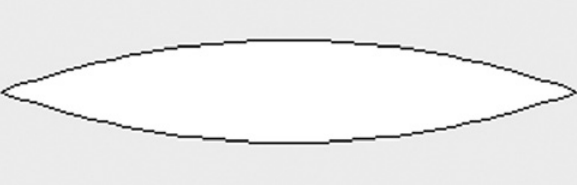
Figure 4: Typical lenticular yarn cross-section